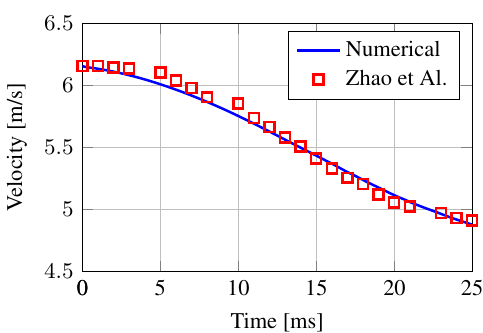
Figure 3. Comparison between numerical and experimental results for the specimen velocity during the water impact of a rigid wedge. Experimental data are retrieved from Reference [78].